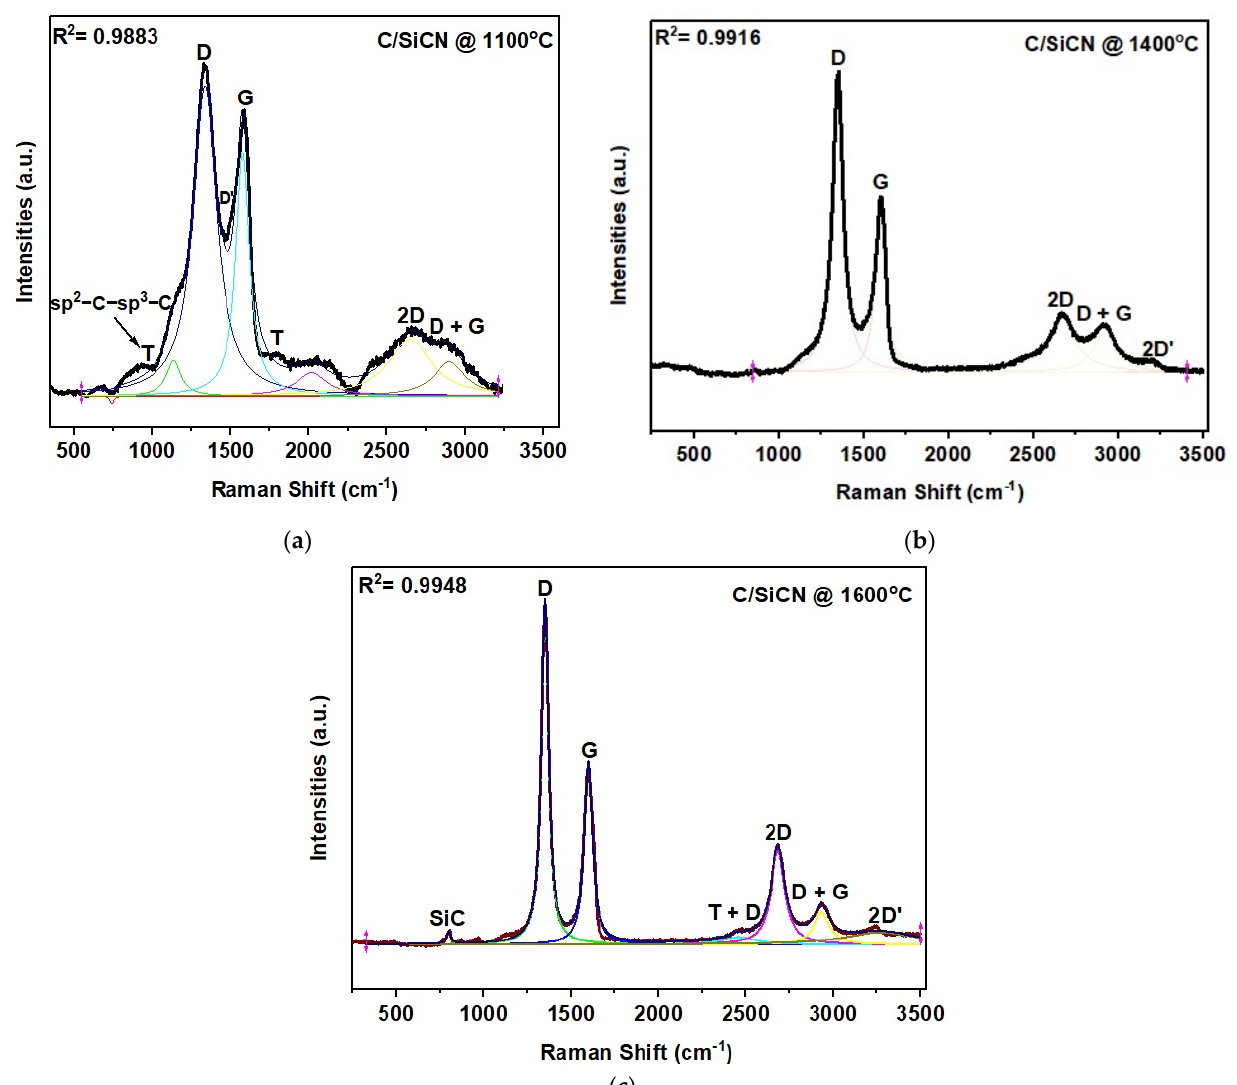
Figure 1. Raman spectra of the C/SiCN nanocomposites showing the carbon phase of various samples represented by the peak position and band parameters: ( a ) Raman spectrum of the amorphous C/SiCN nanocomposite pyrolyzed at 1100 °C; ( b ) Raman spectrum of the C/SiCN nanocomposite annealed at 1400 °C; ( c ) Raman spectrum of the C/SiCN nanocomposite annealed at 1600 °C.